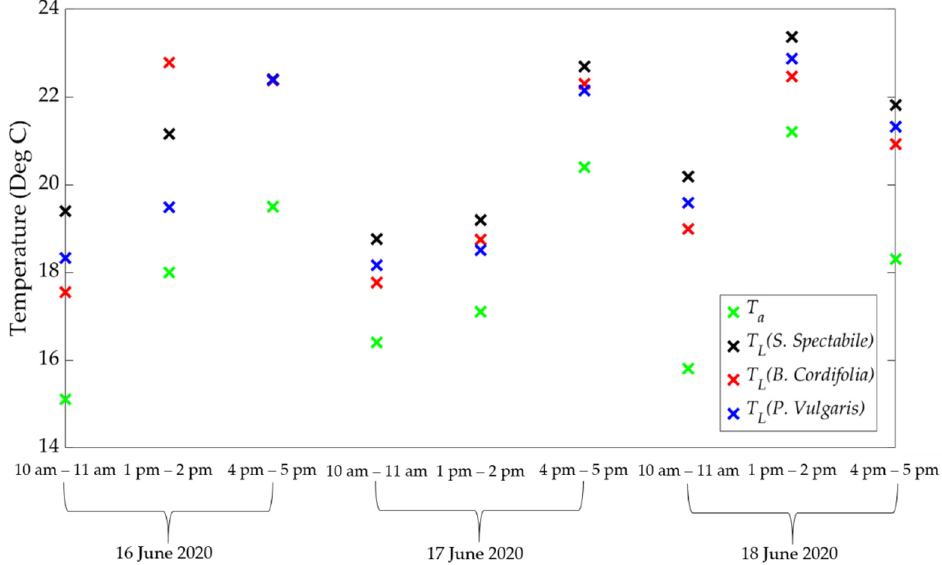
Figure 3. Average leaf temperature (T L ) from S. spectabile , B. cordfolia and P. vulgaris species and local air temperature (T a ) over 9 hourly periods between 16 and 18 June 2020.